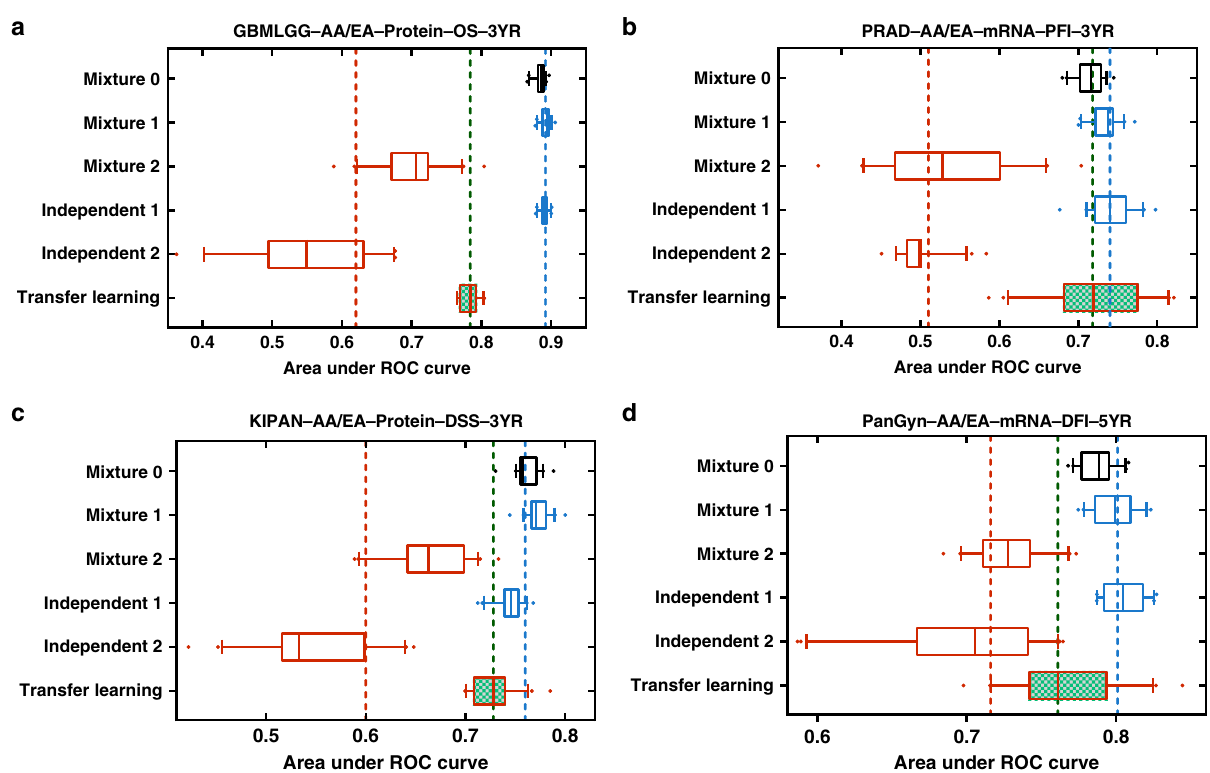
Fig. 3 Comparison of multiethnic machine learning schemes. The machine learning tasks are: a GBMLGG-AA/EA-Protein-OS-3YR, b PRAD-AA/EA- mRNA-PFI-3YR, c KIPAN-AA/EA-Protein-DSS-3YR, d PanGyn-AA/EA-mRNA-DFI-5YR. In each panel, the box plots show AUROC values for the six experiments (20 independent runs for each experiment). The red, blue, and green vertical dash lines represent AUROC AA , AUROC EA , and A Transfer respectively. Box-plot elements are: center line, median; box limits, 25 and 75 percentiles; whiskers, 10 – 90 percentiles; points, outliers. Abbreviations for cancer types are explained in Supplementary Data